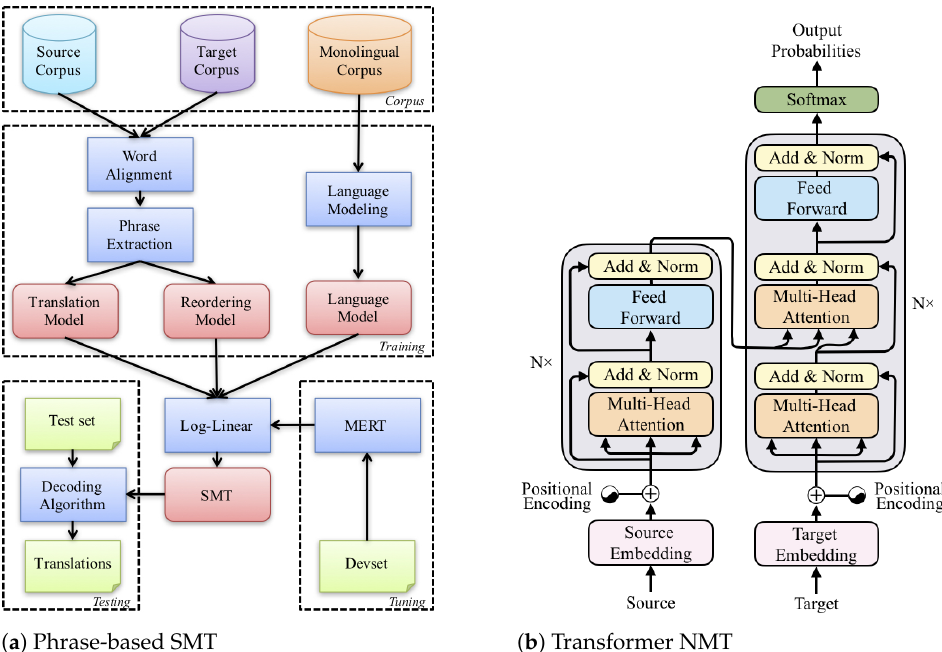
Figure 1. Architectures of the ( a ) SMT and ( b ) NMT